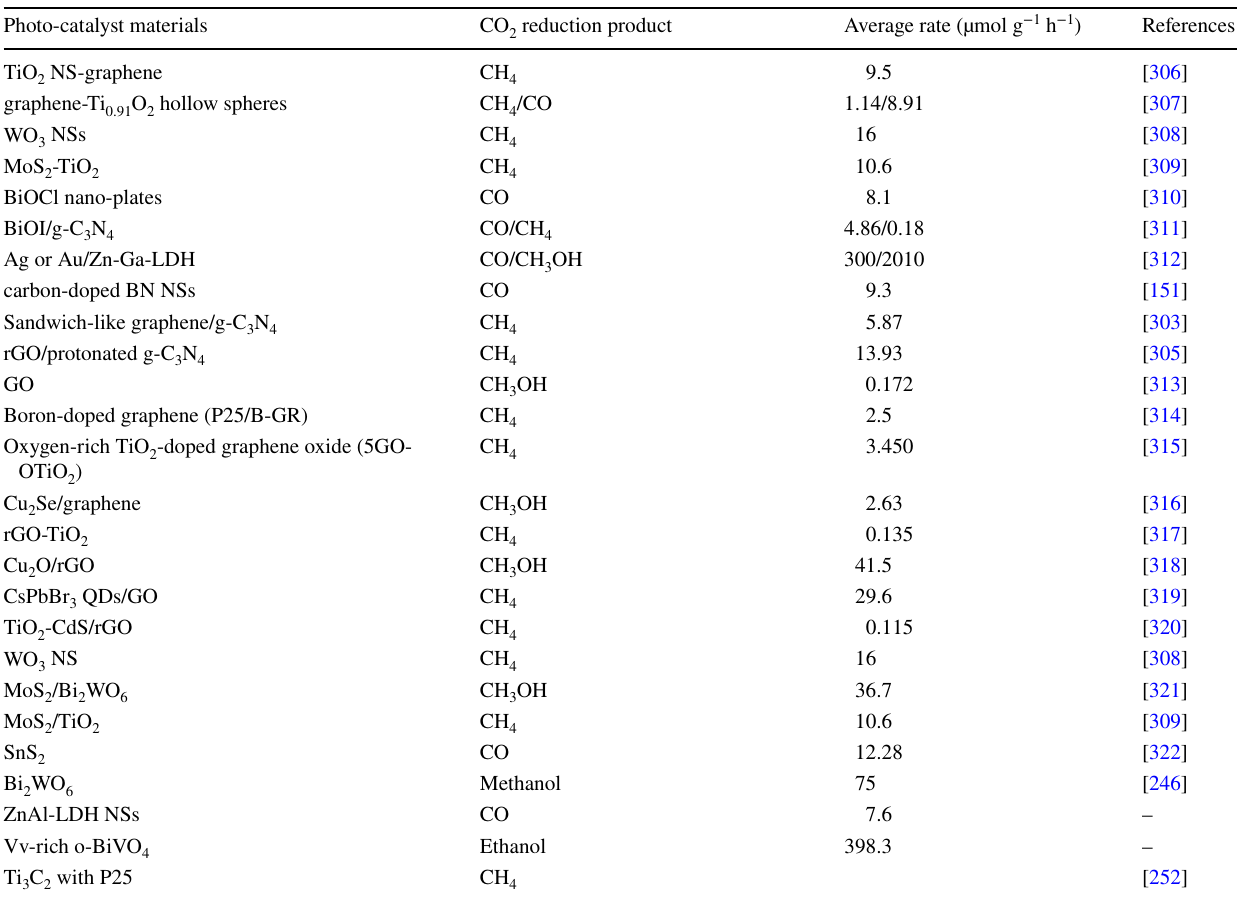
Table 2 Comparison of current developments in 2D materials for solar‑based CO 2 reduction Photo‑catalyst